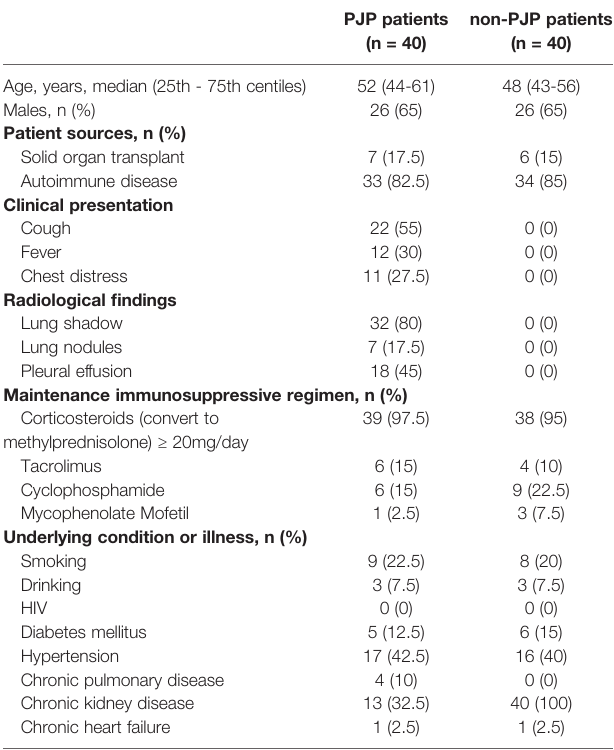
TABLE 1 | The clinical and demographic characteristics of study participants.